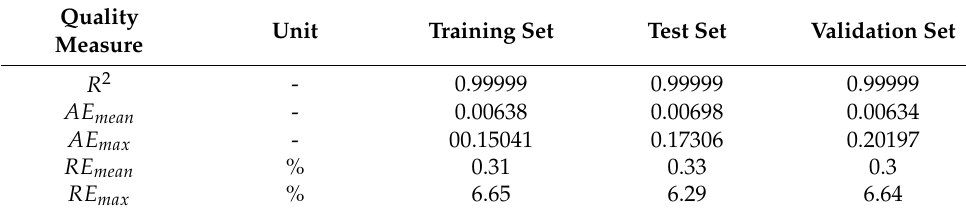
(cid:16) = f t / D b , n , Π δ Q